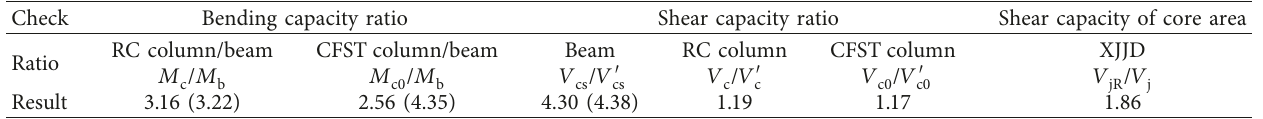
Table 2: Specimen bearing capacities.